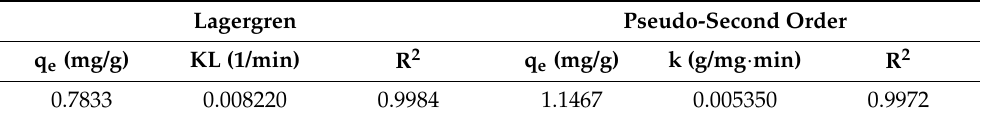
Figure 9. Adsorption kinetic comparison between experiments and models. The Mn − Ti modified zeolite (2 g) was mixed in a 0.1 L solution with 1 × 10 − 2 g/L initial fluoride concentration at 25 °C and PH = 7 and the test time was 4 h. Table 2. Fitted parameters of kinetic